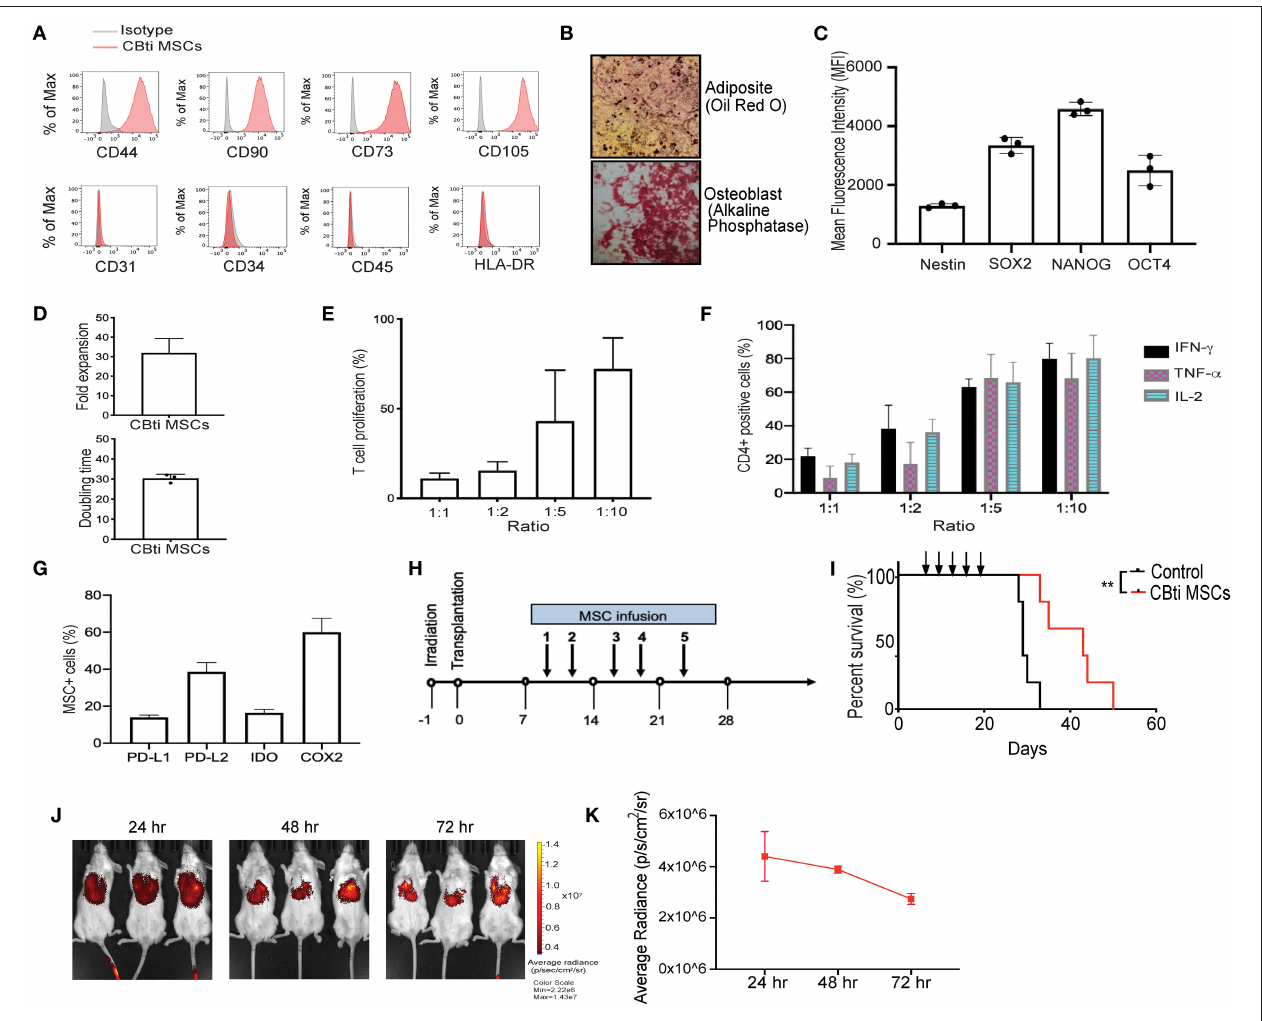
FIGURE 1 | Characteristics of human cord blood tissue (CBti) derived MSC. (A) Representative histograms showing the expression of typical MSC markers on cord blood tissue derived MSC (28) compared to isotype control (gray) ( n = 4). (B) Representative immunostaining slides showing differentiation of cord blood derived MSC into adipocytes shown by Oil Red O stain (upper panel) or osteoblasts shown by alkaline phosphatase staining (lower panel) ( n = 2). Magnification × 40. (C) Bar graphs showing the Median Fluorescence Intensity (MFI) of pluripotency markers by CBti derived MSC as assessed by flow cytometry. (D) Bar graphs showing doubling time (upper graph) fold expansion (lower graph) of CBti MSC (28) ( n = 4). The bars represent mean values with standard deviation of mean. (E,F) Bar graphs showing the immunomodulatory potential of CBti derived MSC (28) in terms of (E) Percentage of T cell proliferation as compared to positive control after co-culture with MSC at different ratios ( n = 3). (F) Bar graph showing the reduction of IFN-y (black bar), TNF- α (purple bar), and IL-2 (green bar) secretion by activated T cells ( n = 7). (G) Bar graphs showing the percentage of MSCs cord tissue that express the immunomodulatory factors PD-L1, PD-L2, IDO, and COX-2. (H) Scheme of xenogeneic GVHD mice model. (I) Overall survival of a xenograft GVHD model comparing control mice (injected with PBS, black line), and mice injected with CBti derived MSC (red line) ( n = 5 per group). Arrows indicated the days of injection. (J,K) Biodistribution of DiR-labeled CBti MSCs in the same xenograft mouse model of GVHD described in panels G-I over a course of 72h. (J) Fluorescent images of 3 representative mice per group (K) Plot of average radiance of injected CBti derived MSC showing the standard